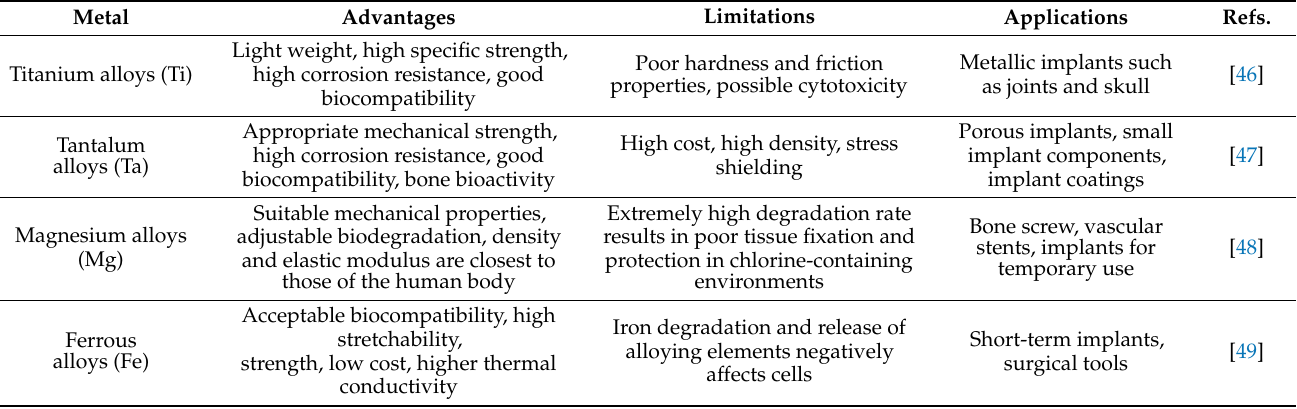
Table 2. Advantages and disadvantages of common metals and their applications in bone tissue